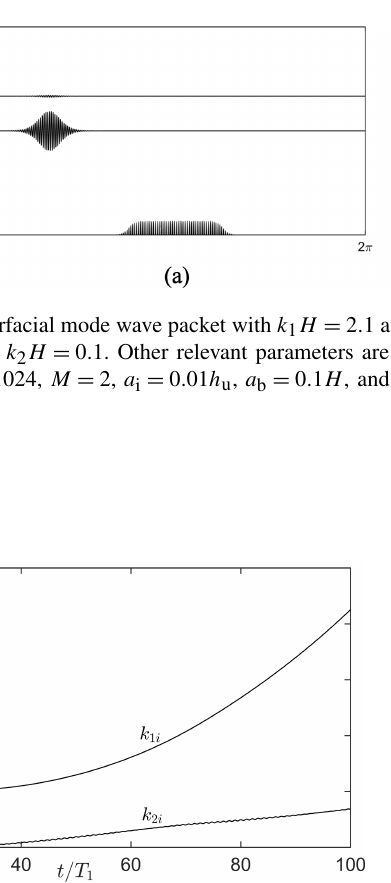
Figure 4. (a) Dispersion curves for a uniform current (flowing over a stationary bottom boundary). U ∗ u = U ∗ and ρ u /ρ l = 0 . 95. (b) Dispersion curves for shear in the bottom layer and single density fluid. U ∗ u = U ∗ ρ u = ρ l . Dashed curves have negative energy. U has been non-dimensionalized with